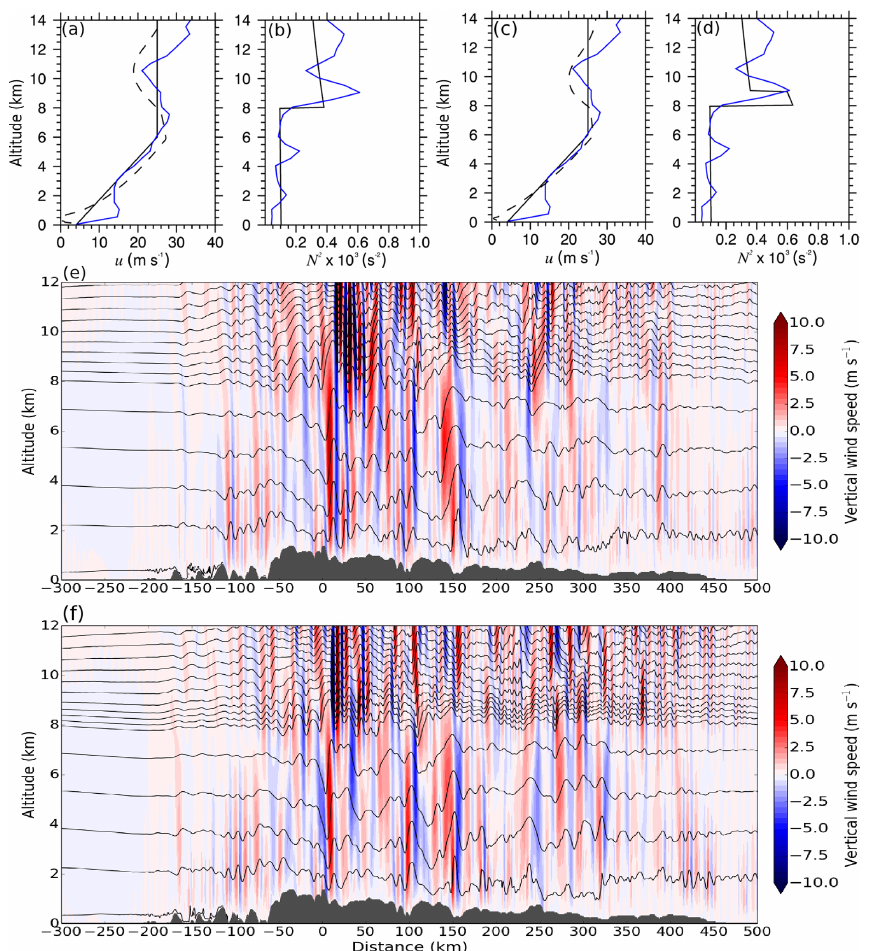
Figure 14. Initial profiles (black solid) and vertical velocity for the simulations with more realistic terrain without TIL ( a, b, e ; run 5) and with TIL ( c, d, f ; run 6). The initial profiles approximate the background conditions over southern Scandinavia on 28 January 2016 (blue profiles show the Stavanger radiosonde data). Negative shear above the tropopause establishes in the course of the simulations ( a, c ; dashed black, time of 16h, distance of −